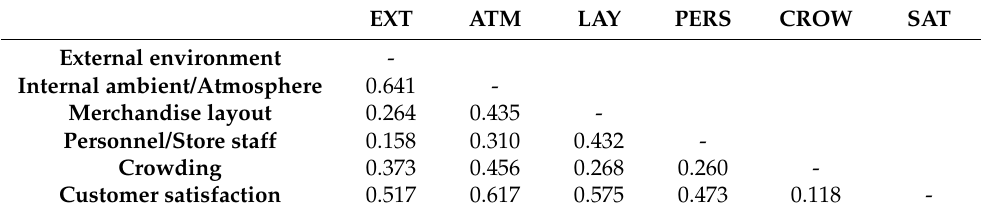
Table 3. Correlations and discriminant validity values (Hedonic shopping) (EXT: external environ- ment; ATM: internal ambient; LAY: merchandise layout; PERS: personnel; CROW: crowding; SAT: customer